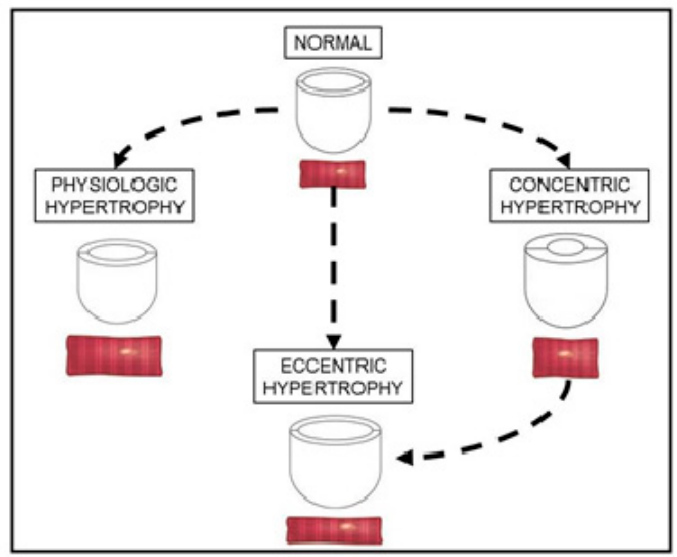
Figure 1. Simplified view of cardiac hypertrophy. The normal heart develops left ventricular remodeling in response to physiological (exercise and pregnancy) and pathological (pressure or volume overload, myocardial infarction, hypertension, drug toxicity, and congenital heart defects) stimuli. In the physiological hypertrophy, cardiomyocytes increase in length and width. In the concentric hypertrophy, cardiomyocytes mostly increase in width compared with length. In the eccentric hypertrophy, cardiomyocytes mostly grow in length compared with width, leading to dilated cardiomyopathy. Except for physiological hypertrophy, hypertrophic remodeling can progress to contractile dysfunction and heart failure.